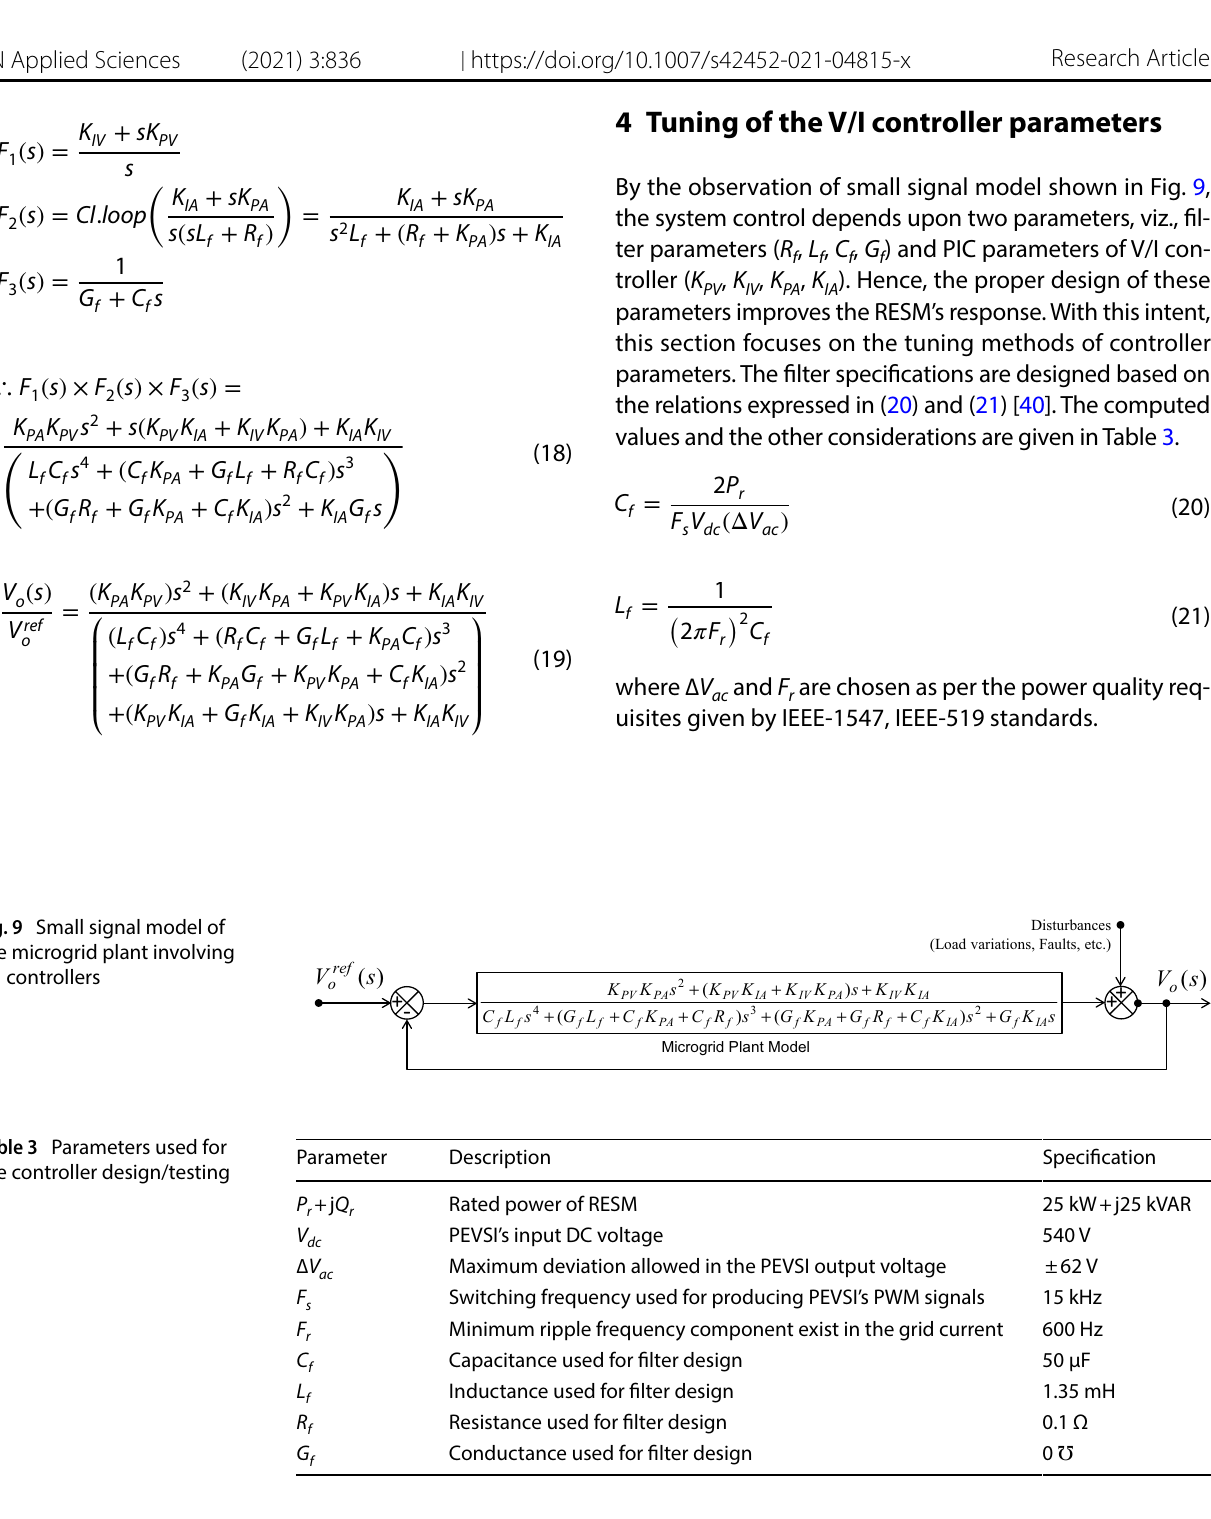
Table 4 Steps involved in OLTR and EPI tuning methods Step-1 Remove all the feedback/feedforward loops and the controller from the plant, so that no control action involved in the plant response Step-2 Excite the plant with a step input and observe its open-loop response as referred in Fig. 10 Step-3 By using the inflection point as the basis, draw the tangent to this open-loop curve. From this, measure the value of dead time ( T time constant ( τ ), stationary gain ( K ), and tangent slope ( M ) c s Step-4 Compute the PI specifications using Tables 5 and 6 [41, 42]. The corresponding computed values are given in Table